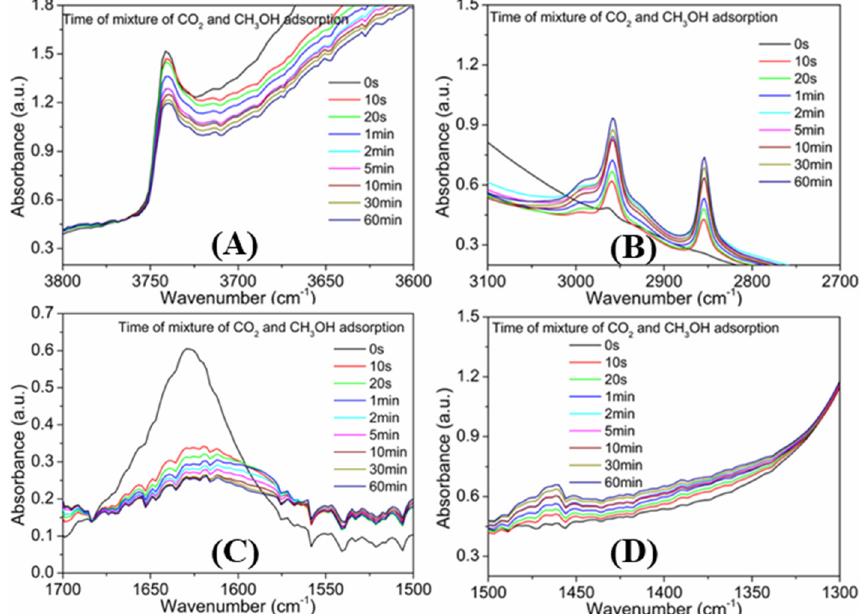
Figure 9. Infrared spectra of the co-adsorption of CH 3 OH and CO 2 over Zr-SBA-15 in the regions of 3800 cm − 1 –3600 cm − 1 ( A ), infrared spectra of the co-adsorption of CH 3 OH and CO 2 over Zr-SBA-15 in the regions of 2700 cm − 1 –3100 cm − 1 ( B ), infrared spectra of the co-adsorption of CH 3 OH and CO 2 over Zr-SBA-15 in the regions of 1500 cm − 1 –1700 cm − 1 ( C ), infrared spectra of the co-adsorption of CH 3 OH and CO 2 over Zr-SBA-15 in the regions of 1300 cm − 1 –1500 cm − 1 ( D ).